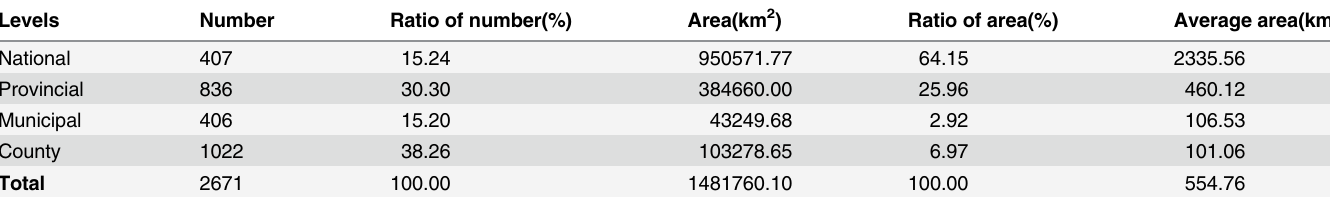
Table 2. Statistics for NR levels in mainland China.